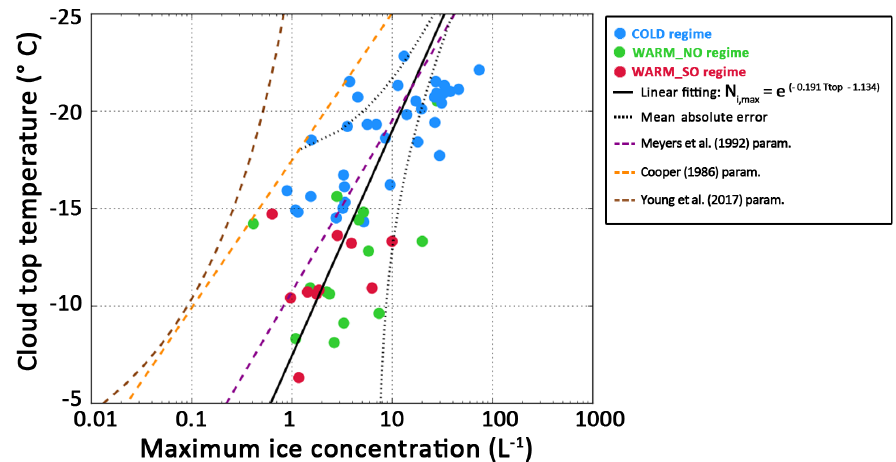
Figure 9. Maximum ice crystal concentration as a function of cloud top temperature. The colored circles represent the values for each profile (with fitting in the black solid line and mean absolute error in dotted lines). The Meyers et al. (1992), Cooper (1986) and Young et al. (2017) parameterizations are also displayed in purple, orange and brown dashed lines,